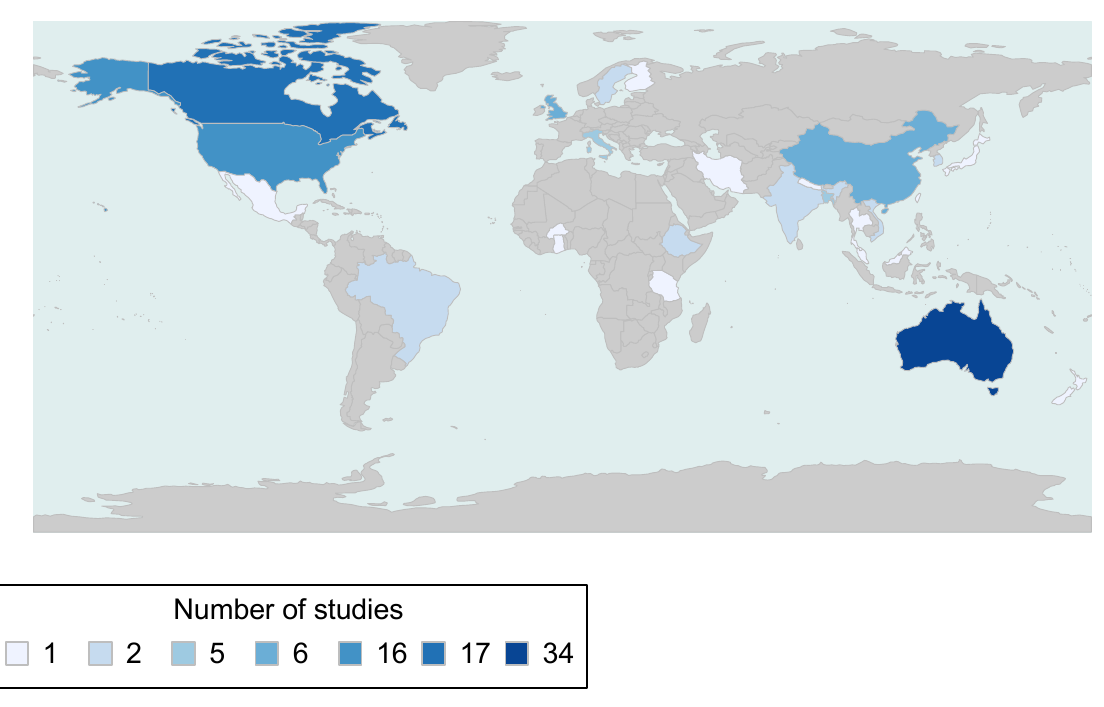
Figure 2. Map of included studies.